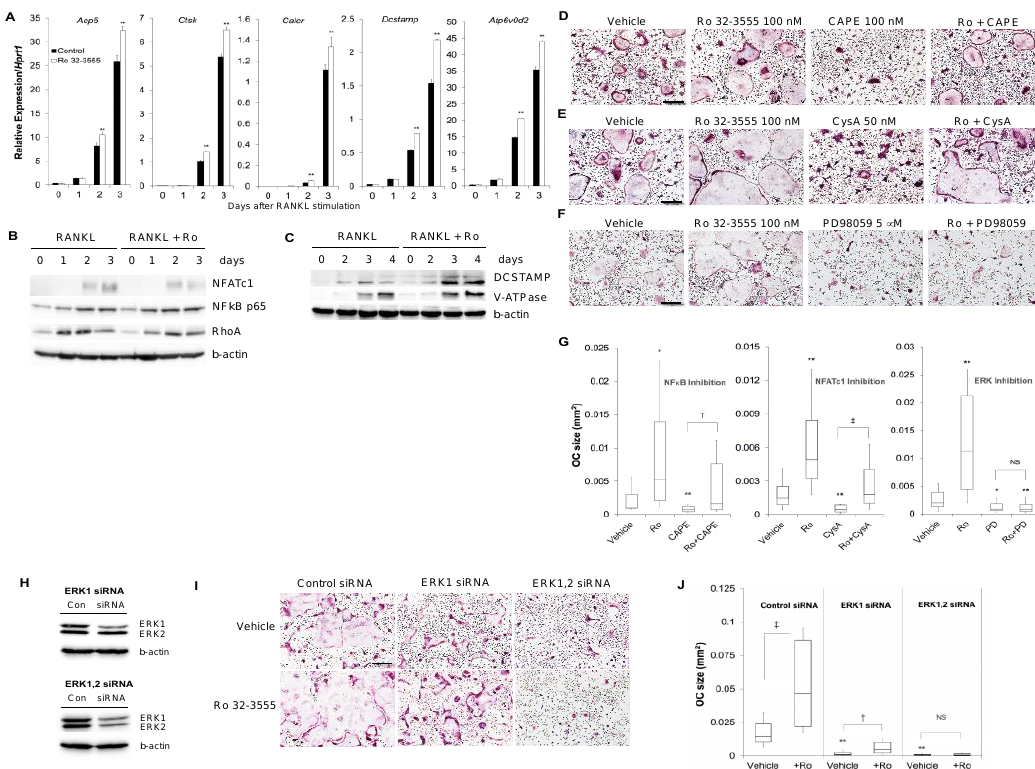
Figure 4. Signaling pathways involved in the increased osteoclast size after collagenase inhibition. ( A ) Control or Ro 32-3555-treated (100 nM) cells were subjected to the real-time RT-PCR analyses for the expression of osteoclast marker genes, TRAP (Acp5) , Cathepsin K (Ctsk) , Calcitonin Receptor (Calcr) , Dcstamp , and v-ATPase (Atp6v0d2) . ( B and C ) BMMs were cultured with M-CSF and RANKL for indicated days in the absence or presence of 100 nM Ro 32-3555. Western blot analyses were performed using cell lysates to examine the expression of proteins involved in osteoclast differentiation and fusion. ( D – F ) BMMs were cultured for 5 days with M-CSF and RANKL. The effect of NFκB inhibitor caffeic acid phenetyl ester (CAPE) ( D ), nuclear factor of activated T-cells, cytoplasmic 1 (NFATc1) inhibitor cyclosporin A ( E ), and ERK inhibitor PD98059 ( F ) on osteoclast size in Ro 32-3555-stimulated cells was tested by TRAP staining. ( G ) The osteoclast size was measured from experiments in ( D – F ). ( H ) BMMs were transfected with ERK1 siRNA (upper panel) or ERK1 and ERK2 siRNA (lower panel). The expression of ERK1 and ERK2 was examined by Western blot after 48 h incubation in the presence of M-CSF. ( I ) Cells in ( H ) were incubated with M-CSF and RANKL for 4 days in the presence or absence of 100 nM Ro 32-3555 before TRAP staining. ( J ) The size of osteoclasts in ( I ) was measured. Data are mean ± SD representative of three independent experiments. *, p < 0.05. **, p < 0.01 versus control. †, p < 0.05. ††, p < 0.01 between inhibitor-treated groups. Scale bars indicate 100 μm.